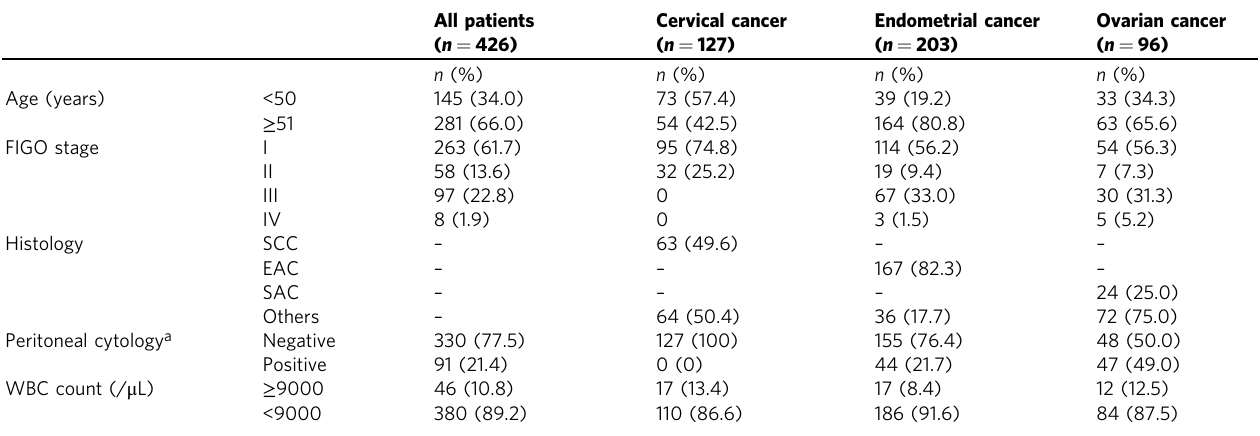
FIGO International Federation of Gynecology and Obstetrics, SCC squamous cell carcinoma, EAC endometrioid adenocarcinoma, SAC serous adenocarcinoma, WBC white blood cell a Peritoneal cytology was not indicated for 4 cases in endometrial cancer and 1 case in ovarian